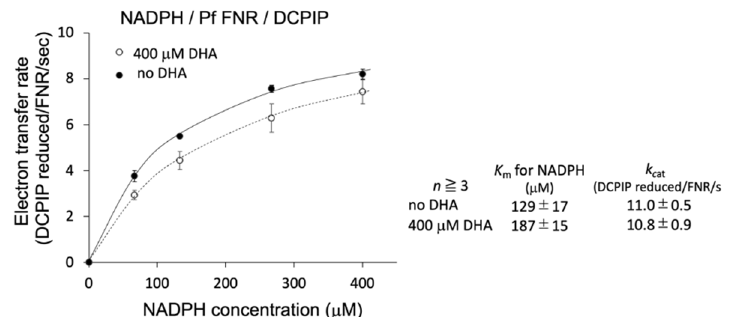
Figure 2. Kinetic analysis of NADPH-dependent diaphorase activity of PfFNR in the absence (closed circles) and presence (400 µM; open circles) of DHA. Each symbol shows the average of the activity, with the error bars representing SD values of at least three measurements. The inlet table shows the average value and SD for the kinetic parameters.